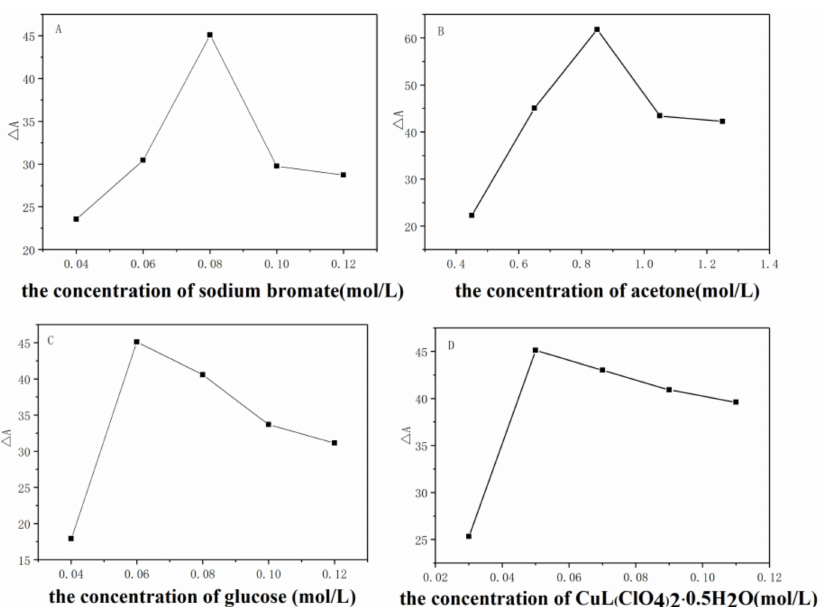
Figure 1. The effect of light while varying the concentration of: ( A ) sodium bromate; ( B ) acetone; ( C ) glucose; ( D ) CuL(ClO 4 ) 2 . Common conditions: [H 2 SO 4 ] 0 = 1.05 M; ultraviolet light applied at 245 nm with an intensity of 1250 Lux.